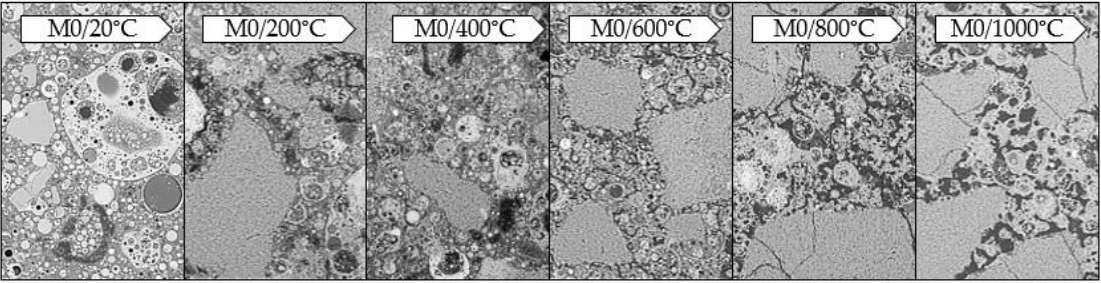
Figure 11. Photographs taken under a scanning microscope using a BSD detector, under variable vacuum conditions, 500 × magnification, EHT 20 kV, WD 7.5–9.5 mm, mortar based on FA only.